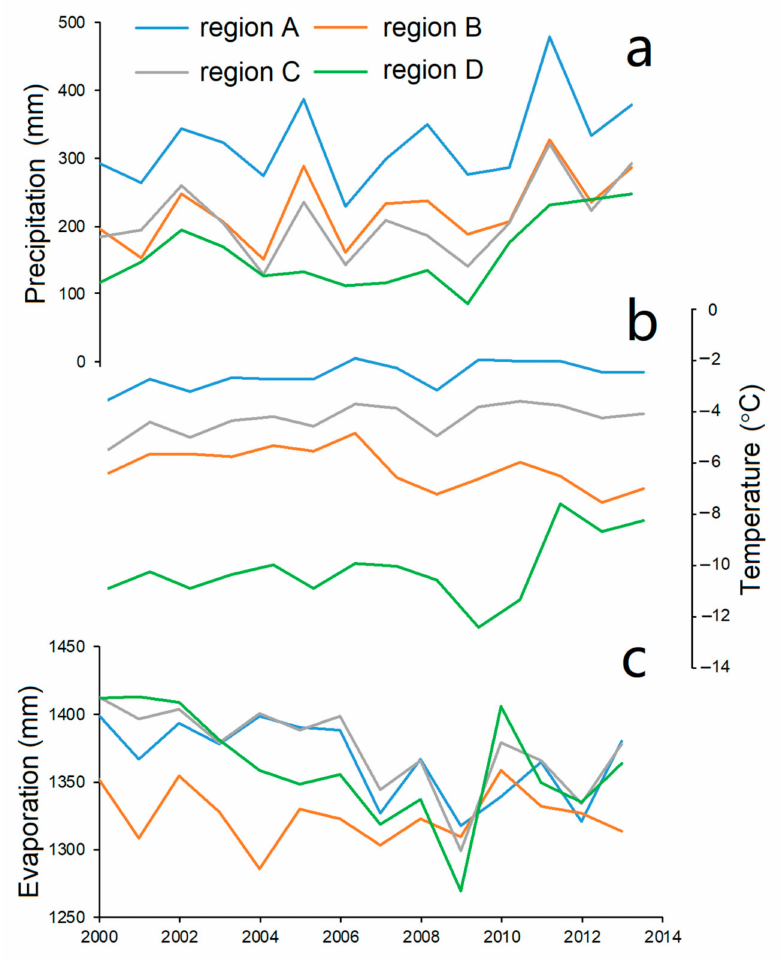
Figure 6. Variation in meteorological elements from 2000 to 2013. ( a ) precipitation; ( b ) temperature; ( c )